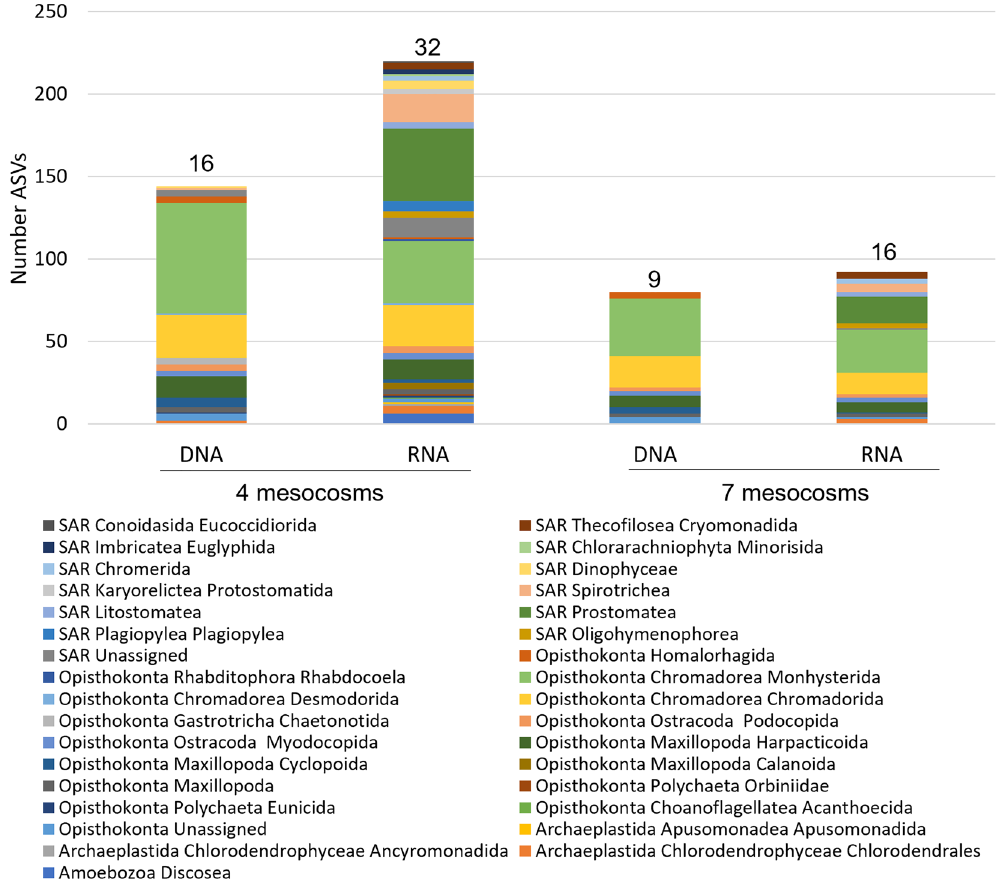
Figure 2. Assigned taxonomy and number of unique sequences (ASVs) detected using the 18S marker for RNA and DNA templates in four and all seven mesocosms. Total number of detected taxa at the Order level for each marker and template stated above the bar. Taxonomy is assigned to